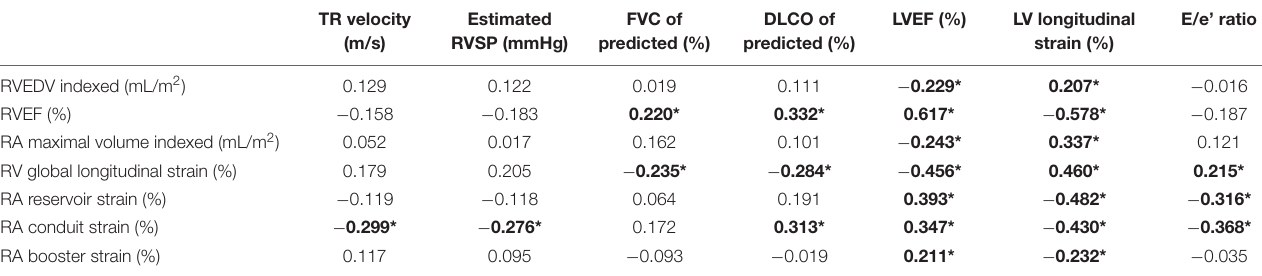
TABLE 3 | Pearson correlation coefficients of right atrial and right ventricular functional parameters with estimated pulmonary arterial pressure on echocardiography, DLCO and left ventricular function.